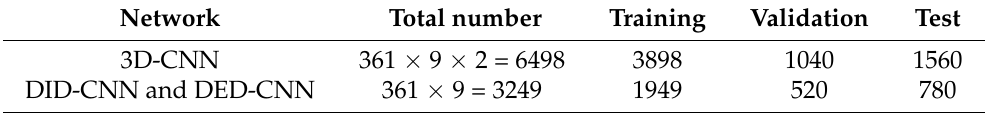
Table 4. The number of training, validation and test images in the presented networks.